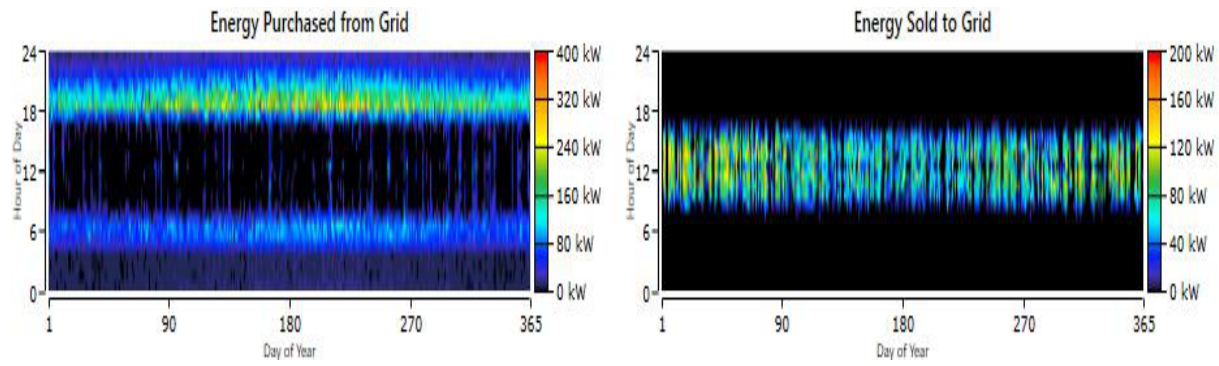
Figure 15. Energy exchange with the grid for company 3.